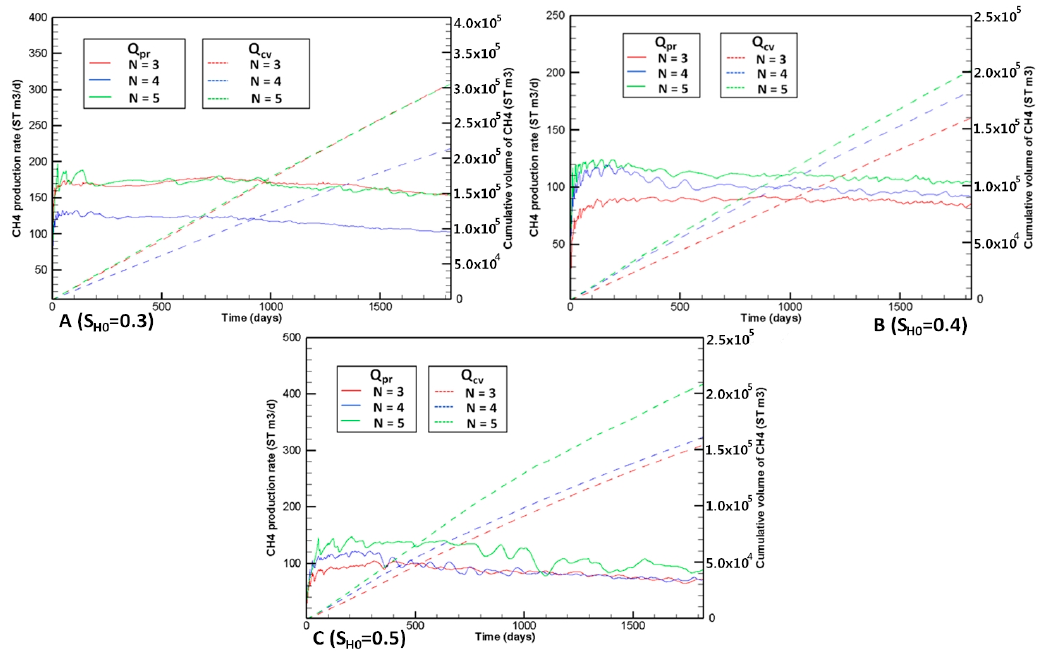
Figure 3. Q pr and Q cv from NGH deposit in the Shenhu area under low-permeability ( k = 7.5 mD) conditions for different N values ( N = 3, 4, and 5). ( A ) S H 0 = 0.3; ( B ) S H 0 = 0.4; ( C ) S H 0 = 0.5.